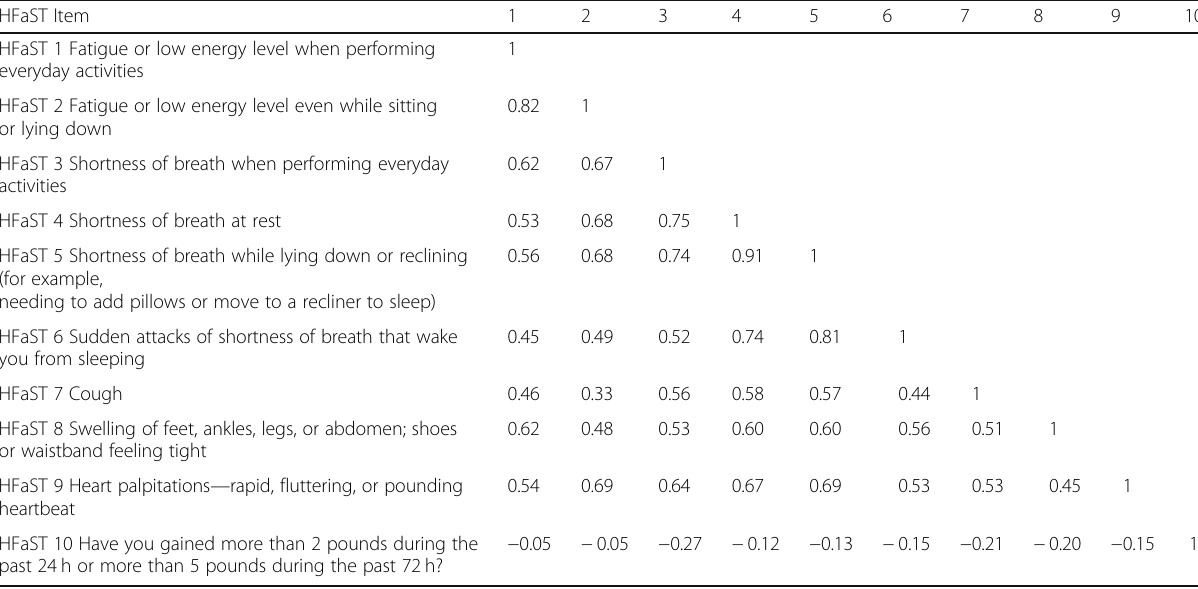
Table 2 Inter-item Correlations on Study Day 4 ( n = 92 to 97) HFaST